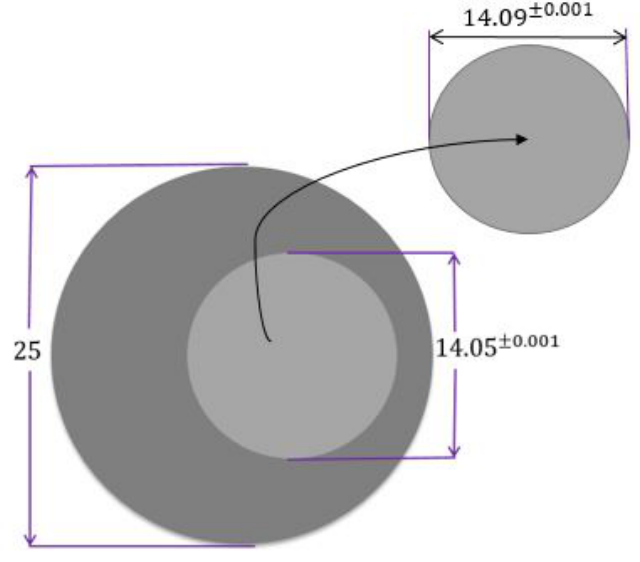
Figure 5. Sample Geometry (all dimensions are in